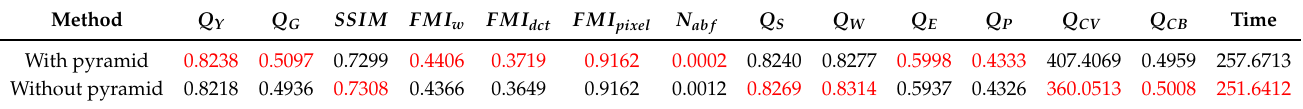
Table 3. The average value of with and without image pyramids on the TNO dataset (unit: seconds). Method